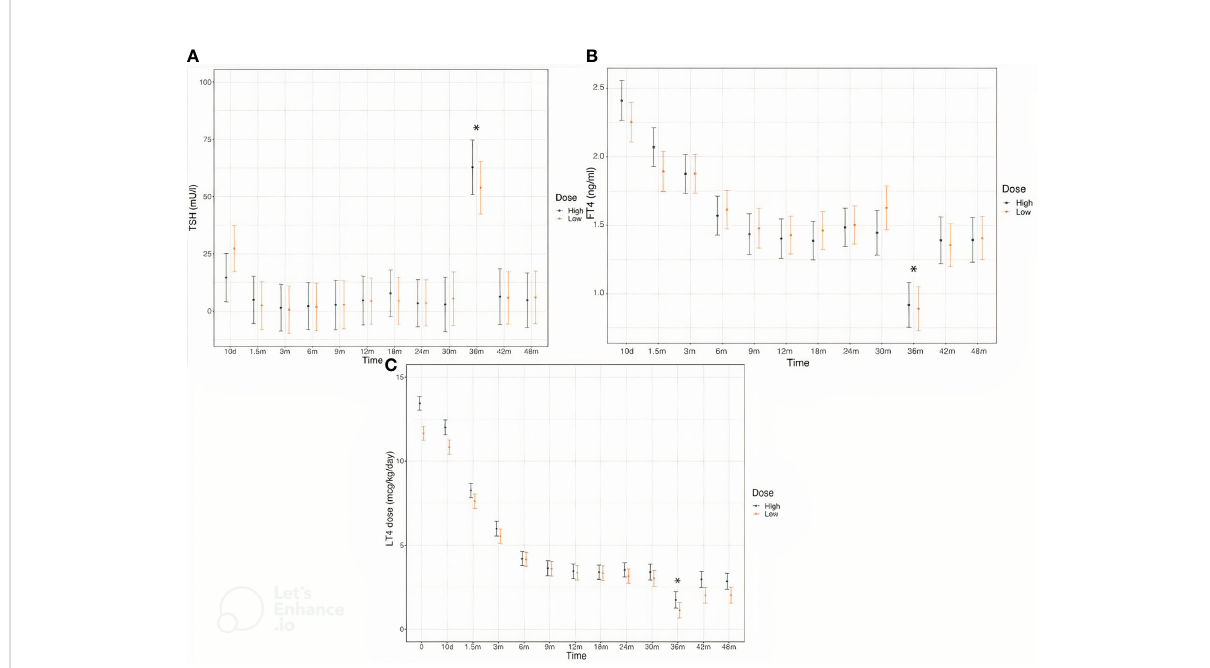
FIGURE 2 Serum concentrations of TSH (A) , FT4 (B) and L-T4 dose (C) in CH patients divided in the two treatment groups throughout the study. According to study protocol, thyroid hormones levels were evaluated at the enrollment, 10 days after L-T4 start and subsequently at the chronological age of 1.5, 3, 6, 9, 12, 18, 24, 30, 36, 42 and 48 months of life. * Changes in TSH and FT4 levels and in L-T4 dose at the age of 3 years are due to L-T4 withdrawal in the majority of patients for the re-evaluation thyroid function.